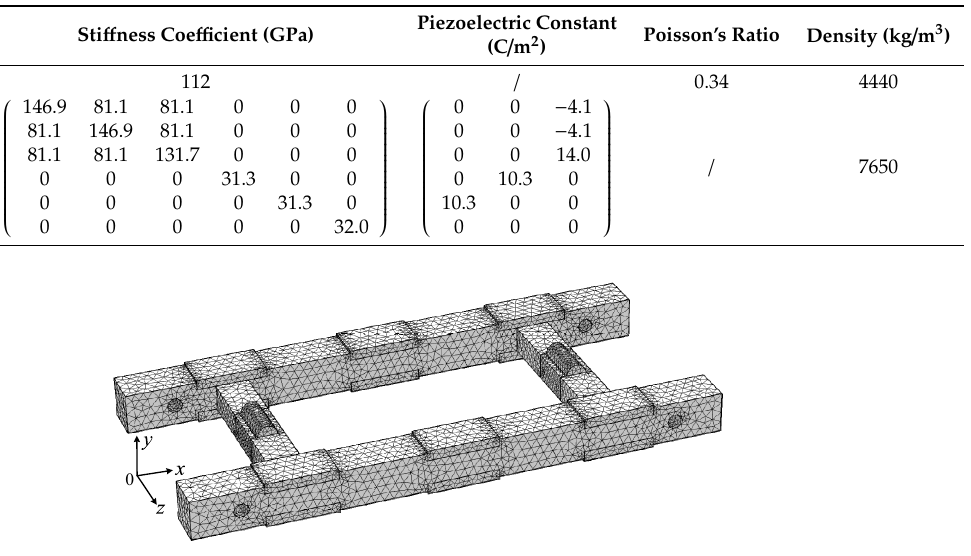
Figure 3. The finite element model of the proposed framed piezoelectric actuator.